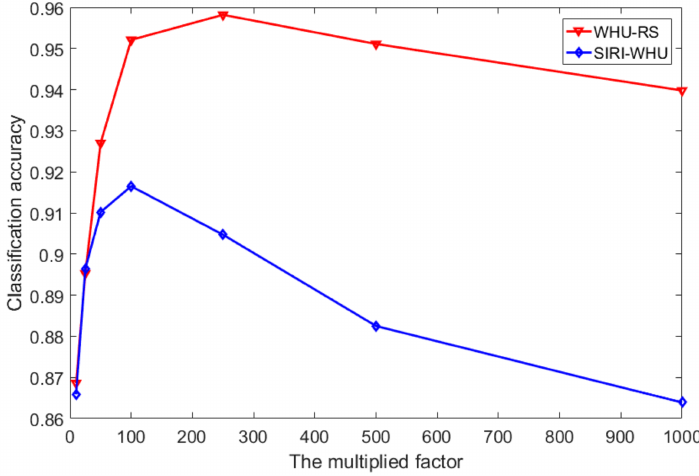
Figure 18. Effect of the multiplied factor k on the classification accuracy in two